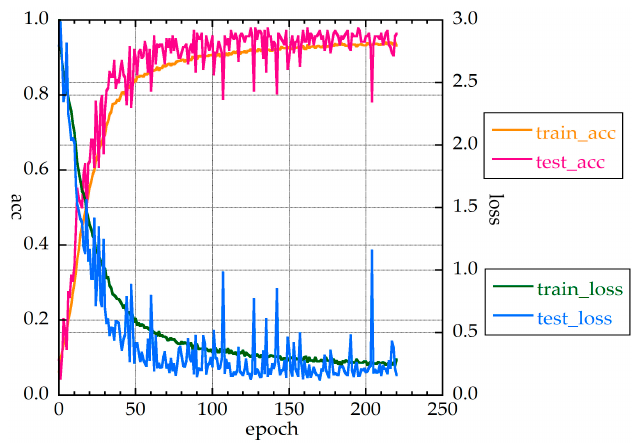
Figure 6. Accuracies and loss function values of MLP_L for 30 measurements without HQ.